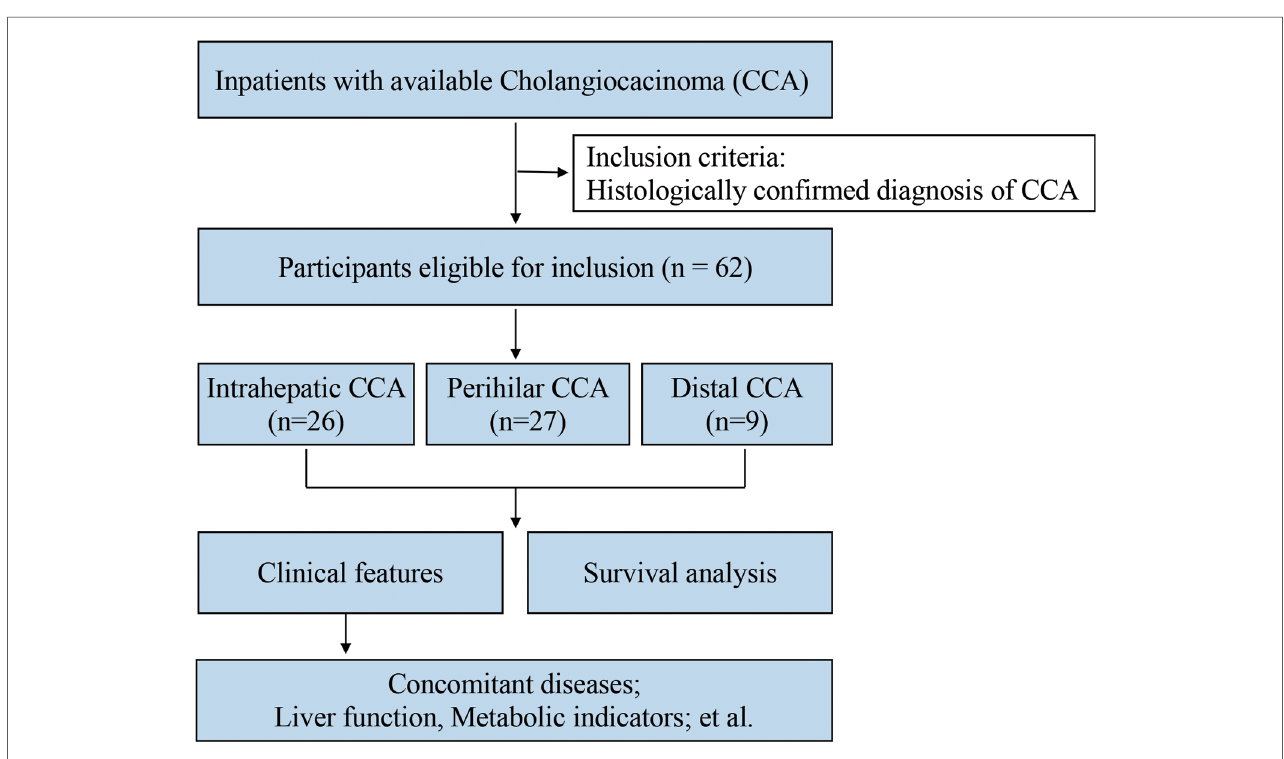
FIGURE 1 Participant